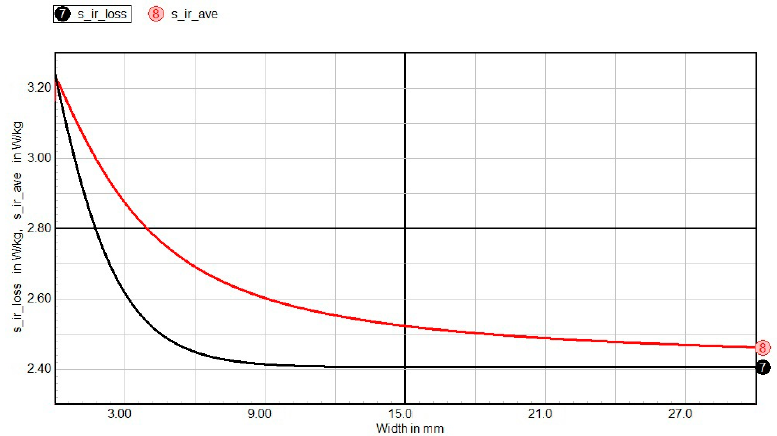
Figure 6. The profiles of local (black) and average specific iron loss (red) (over an actual strip width), obtained from the analytical model ( H max = 3600 A/m, 50 Hz). The strips cut at an angle of 0 degrees. An image from the ICAP/4 postprocessor.